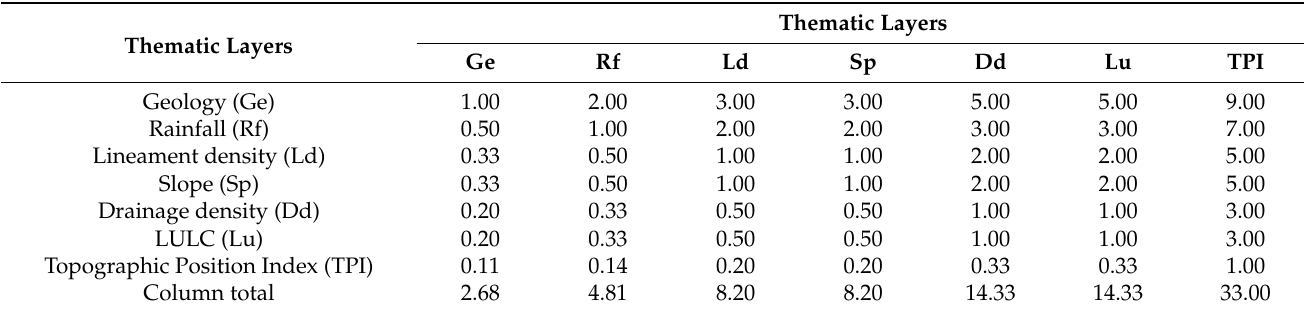
Table 3. Pairwise comparison matrix (PCM) for the seven themes using the AHP technique in Sangaw sub-basin.